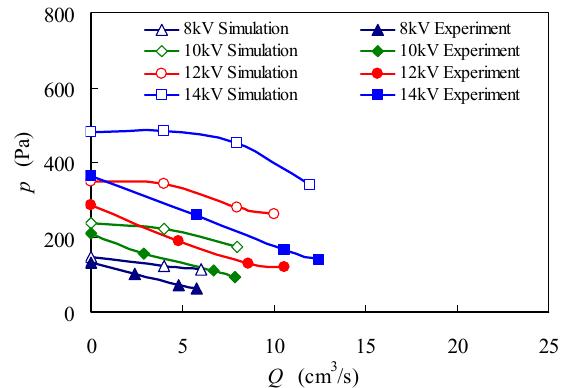
Fig.11 Comparison of measured p-Q characteristic with simulated one for pump with diffuser ( k =7.10×10 -9 C/(V ･ m 2 ), µ